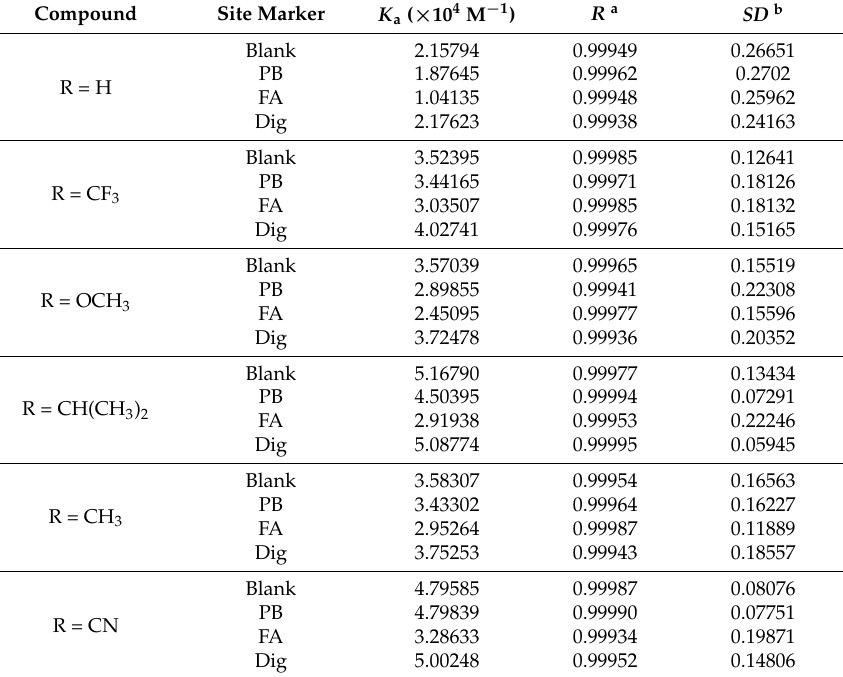
Table 3. Effects of the site probes on the binding constants of PDQL to